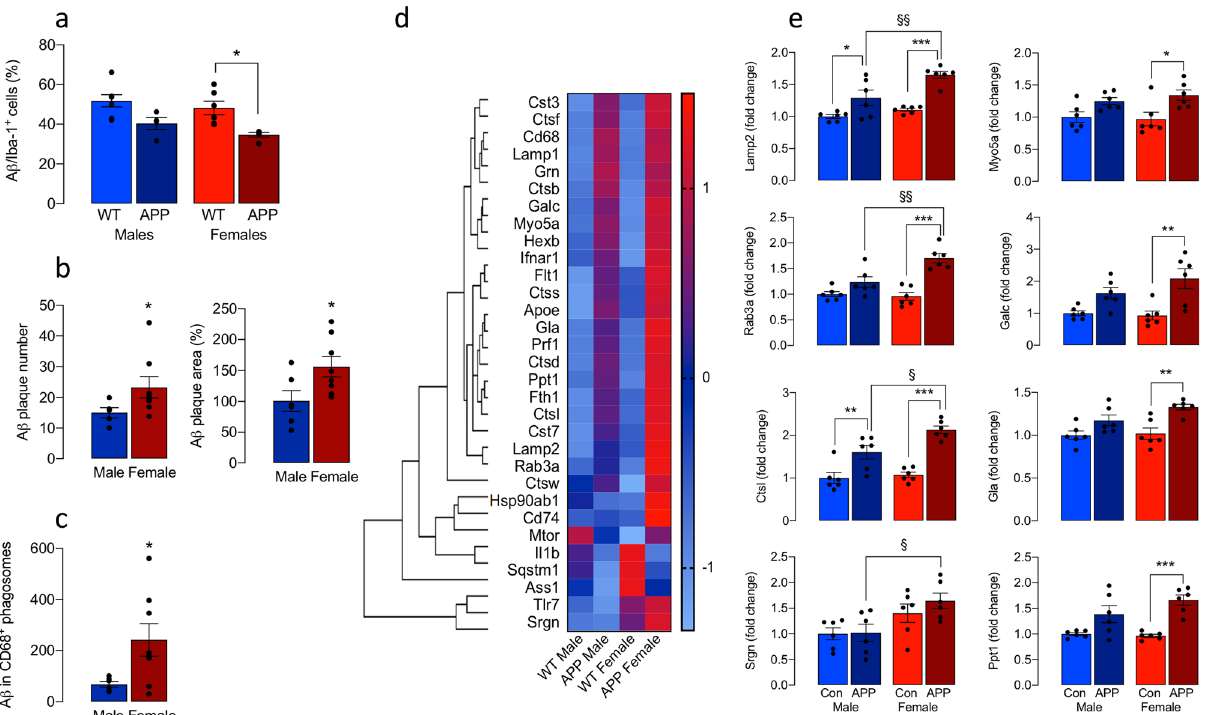
Fig. 6 Differential effect of sex on microglial function. a A β uptake into isolated microglia from female APP/PS1 mice was signi fi cantly reduced compared with microglia from WT mice (* p < 0.05; n = 7, 4, 6, 5 for male WT and APP/PS1 and male WT and APP/PS1 mice, respectively). b ThioS-stained A β plaque number and area were signi fi cantly increased in hippocampal sections from female, compared with male, APP/PS1 mice (* p < 0.05; n = 5 and 8 for male and female mice, respectively). c Phagolysosomal loading with A β was signi fi cantly greater in microglia from female APP/PS1 mice compared with males (* p < 0.05; n = 6 and 8 for male and female mice, respectively). d , e NanoString analysis indicated that lysosomal genes were upregulated in microglia prepared from female APP/PS1 mice compared with the other groups ( d ). Analysis of the mean data, relative to values in WT males, indicated that there were signi fi cant increases in Lamp2 , Myo5A , Rab3A , Ctsl , Cla , Galc , Ppt1 and Srgn in microglia from female APP/PS1 mice compared with female WT mice (* p < 0.05; ** p < 0.01; *** p < 0.001) and compared with male APP/PS1 mice ( § p < 0.05; §§ p < 0.01; n = 6; e ). Data, expressed as means ± SEM, were analysed by 2-way ANOVA and Tukey ’ s post hoc multiple comparison test except for b and c when the Student ’ s t -test for independent means was used to evaluate